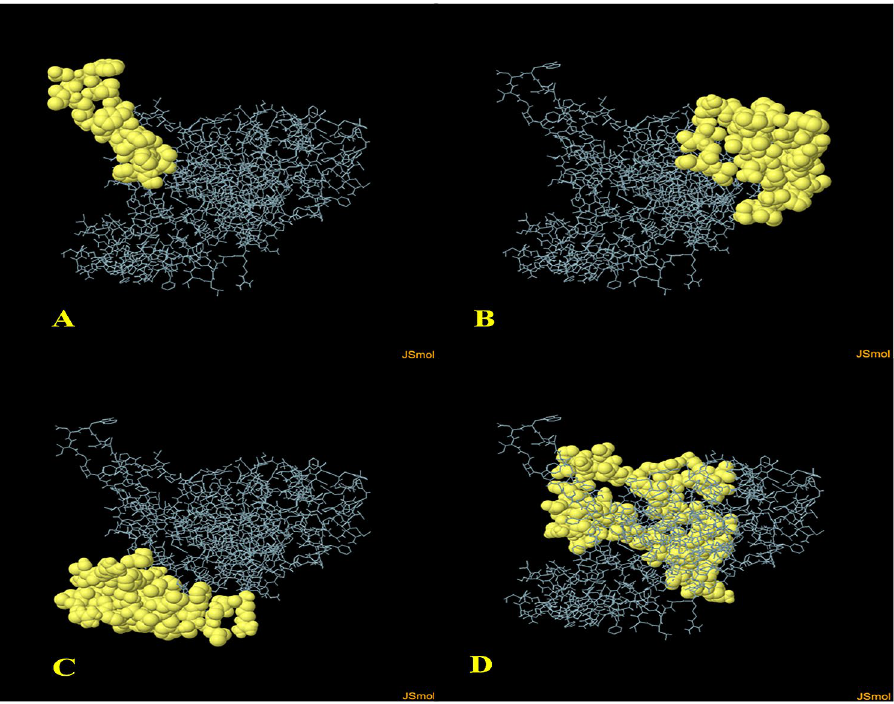
Figure 4. Three-dimensional representation of conformational or discontinuous B cell epitopes of the designed multi-epitope based vaccine. ( A–D ) A yellow surface represents the conformational or discontinuous B cell epitopes, and the bulk of the polyprotein is represented in grey sticks.